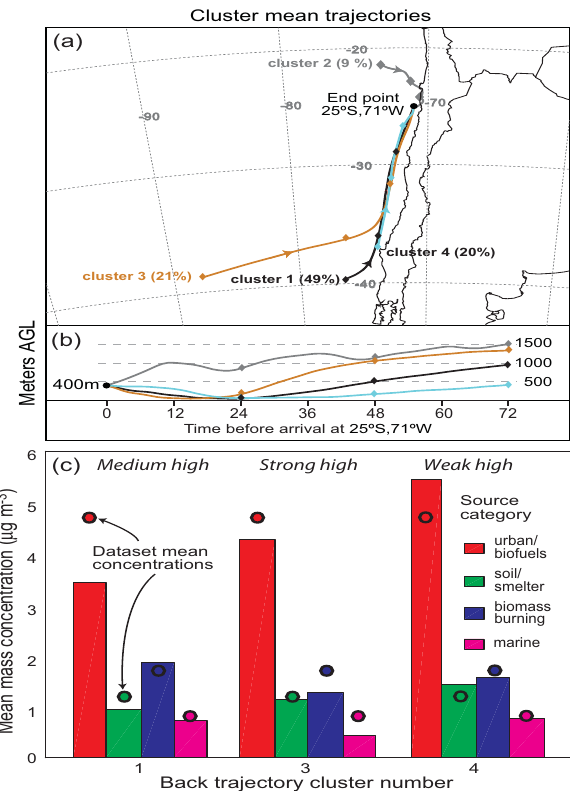
Figure 10 : Mean back trajectories for the four trajectory clusters ending at 400 m above sea- level at 25 ° S, 71 ° W (ocean size just to west of Paposo). A total of 108 back trajectories (72 hour duration) were calculated every 6 hours (ending at 06, 12, 18, 24 UTC at 25 ° S, 71 ° W) using NCEP GDAS model wind fields (horizontal and vertical). Panel (a) shows the location of the mean trajectories, diamonds indicating 24 hour periods prior to arrival at Paposo. The numbers in parentheses give the percentage of the trajectories that fell into each cluster; (b) height of the mean trajectories with colors corresponding to panel (a); (c) Breakdown of aerosol mass by source category for the three most common clusters (1, 3 and 4). Samples were only included in (c) if the trajectories during the filter sampling period were all from the same cluster. The mean mass concentration for the entire set of filter samples (excluding the first which has an excessive mass loading) are shown as filled circles for comparison.